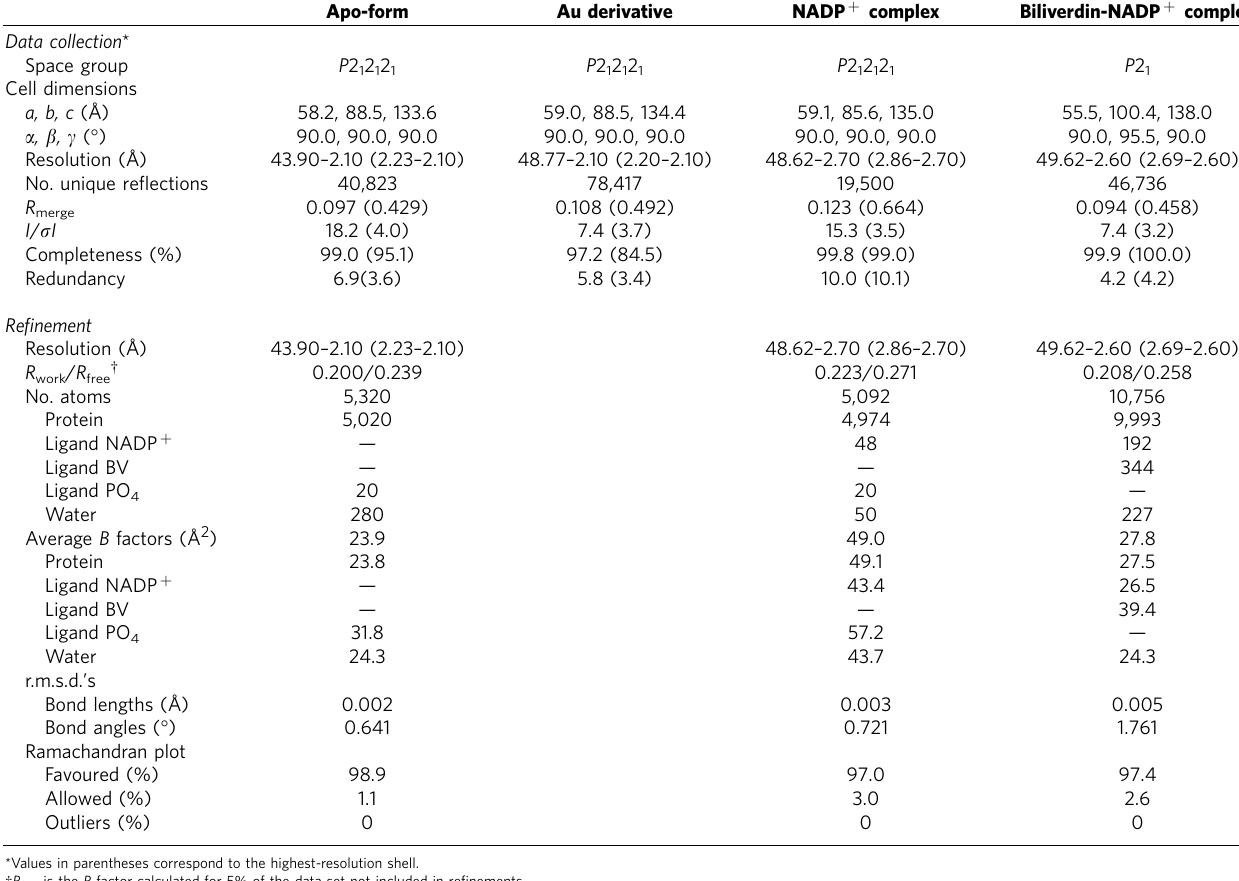
Table 1 | Data collection and refinement statistics.